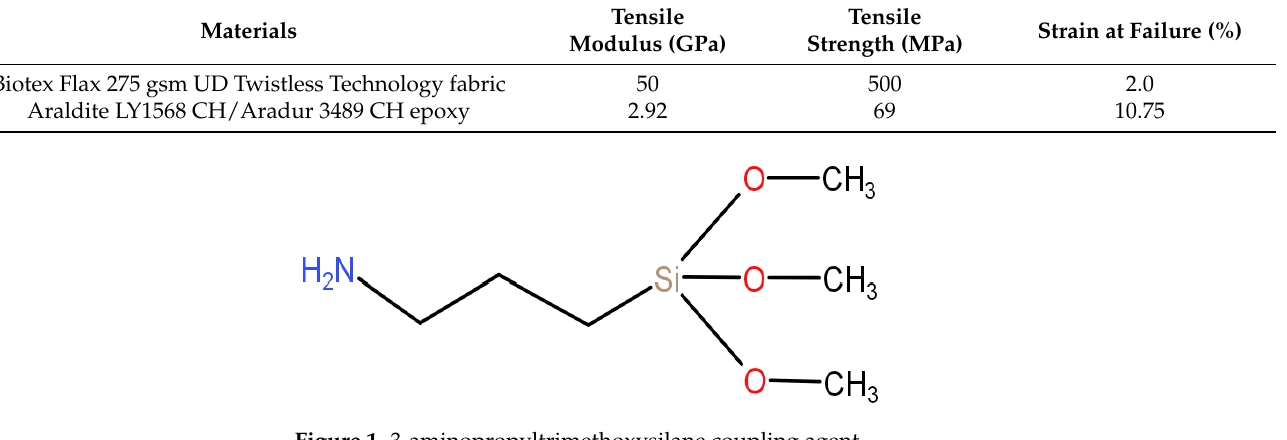
Table 3. Fibre treatment processes applied before composite manufacture.